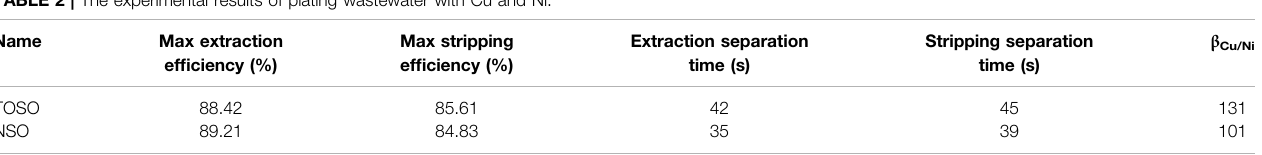
TABLE 2 | The experimental results of plating wastewater with Cu and